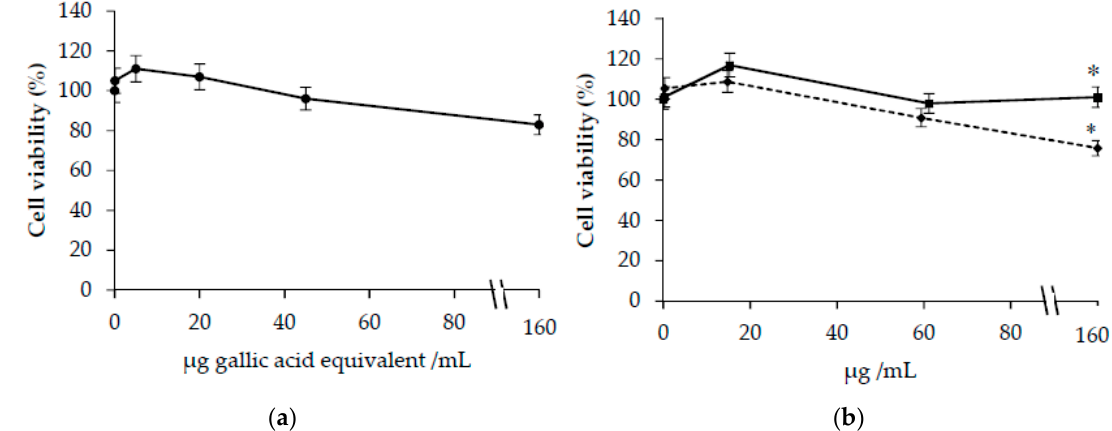
Figure 2. Viability in HuDe cells treated for 48 h in the presence of increasing concentrations of Carthamus Tinctorius (CT) extract ( a ) or hydroxy safflor yellow A (HSYA) ( ) and safflor yellow A (SYA) ( ) ( b ). Phenolic concentrations of CT extract are expressed as μ g gallic acid equivalent/mL. * p < 0.05 vs. cells incubated in the absence of CT extracts or SYA and HSYA.